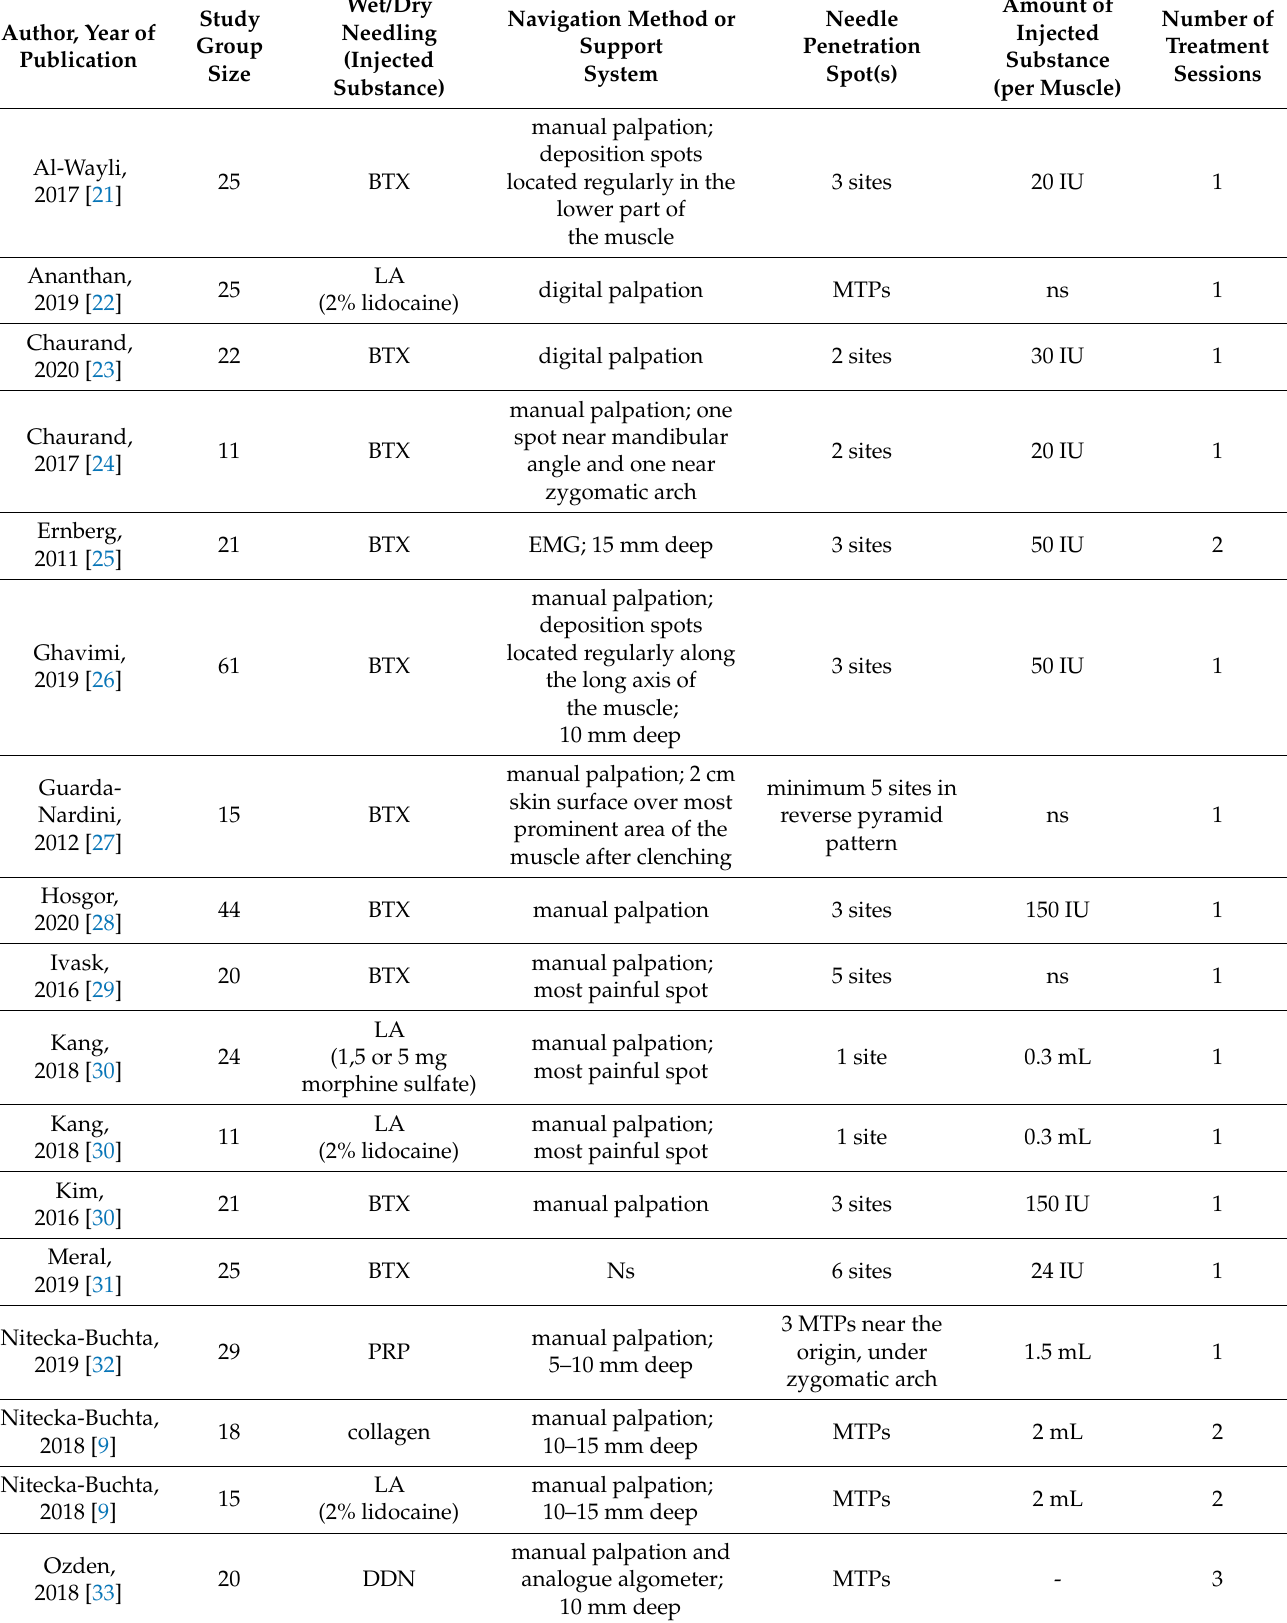
Table 3. Studies regarding masseter muscle